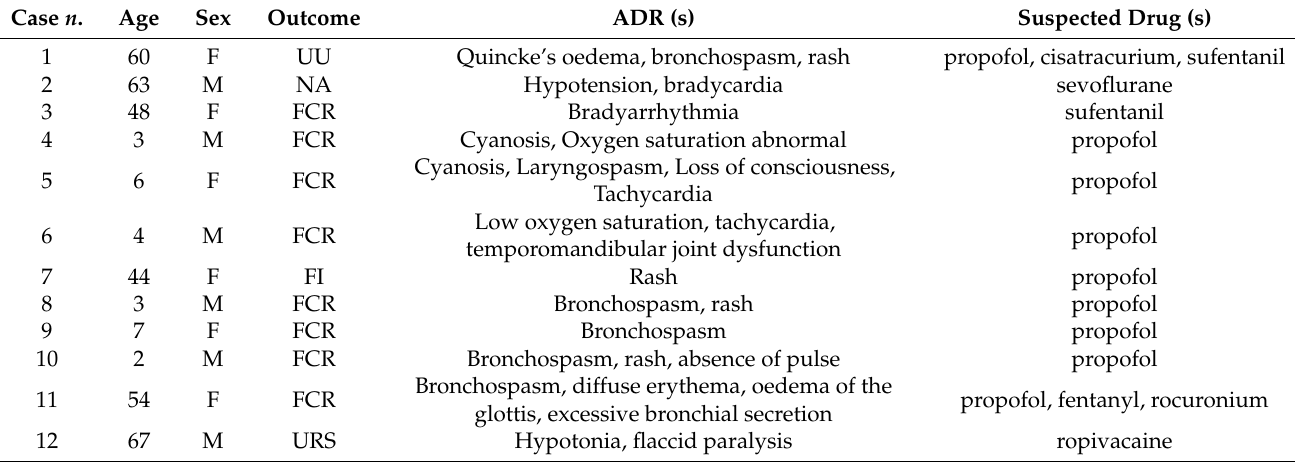
Table 3. Individual Case Safety Reports reporting general or local anaesthetic as suspected drugs and adverse drug reactions that were